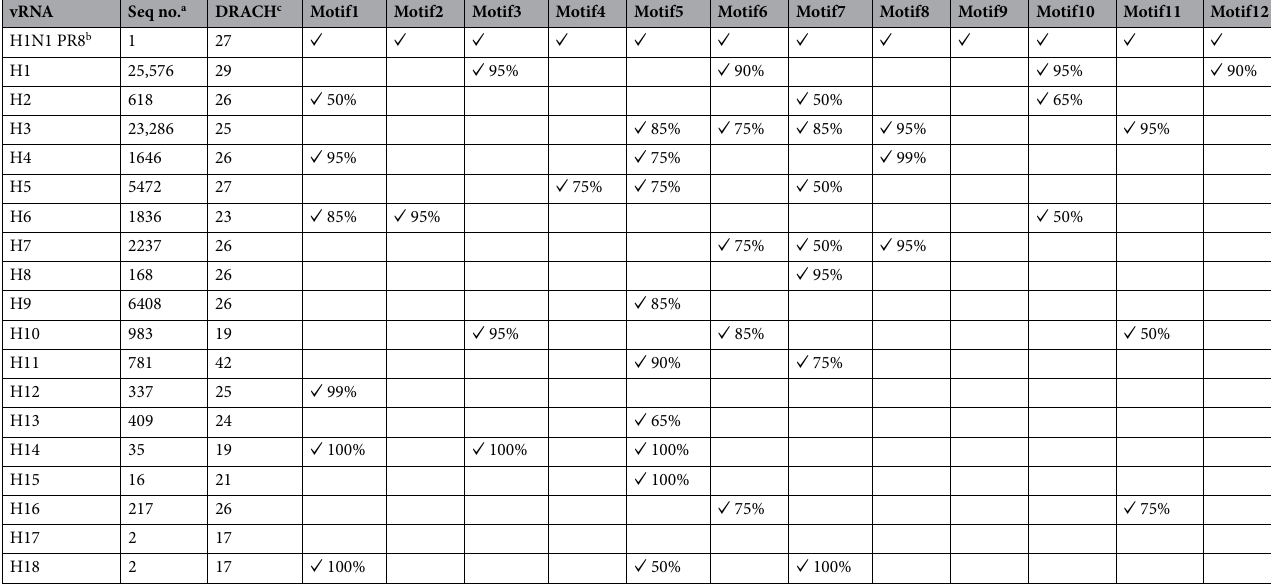
Table 3. Summary of conserved DRACHs distributions among all IAVs HA vRNAs. a The number of HA sequences listed on IRD and analyzed here in this study. b The reference influenza A virus strain utilized in this study, A/Puerto Rico/8/34/Mount Sinai, HA accession no. AF389118. c The total number of the possible DRACH motifs located in the consensus sequence in each